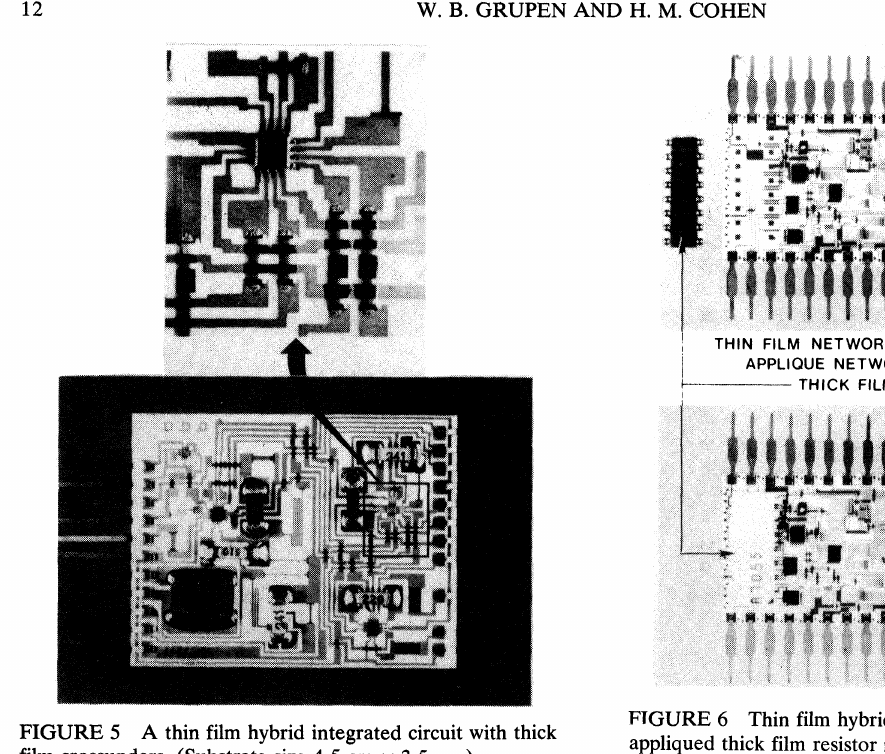
FIGURE 5 A thin film hybrid integrated circuit with thick film crossunders. (Substrate size 4.5 cm 3.5 cm.)